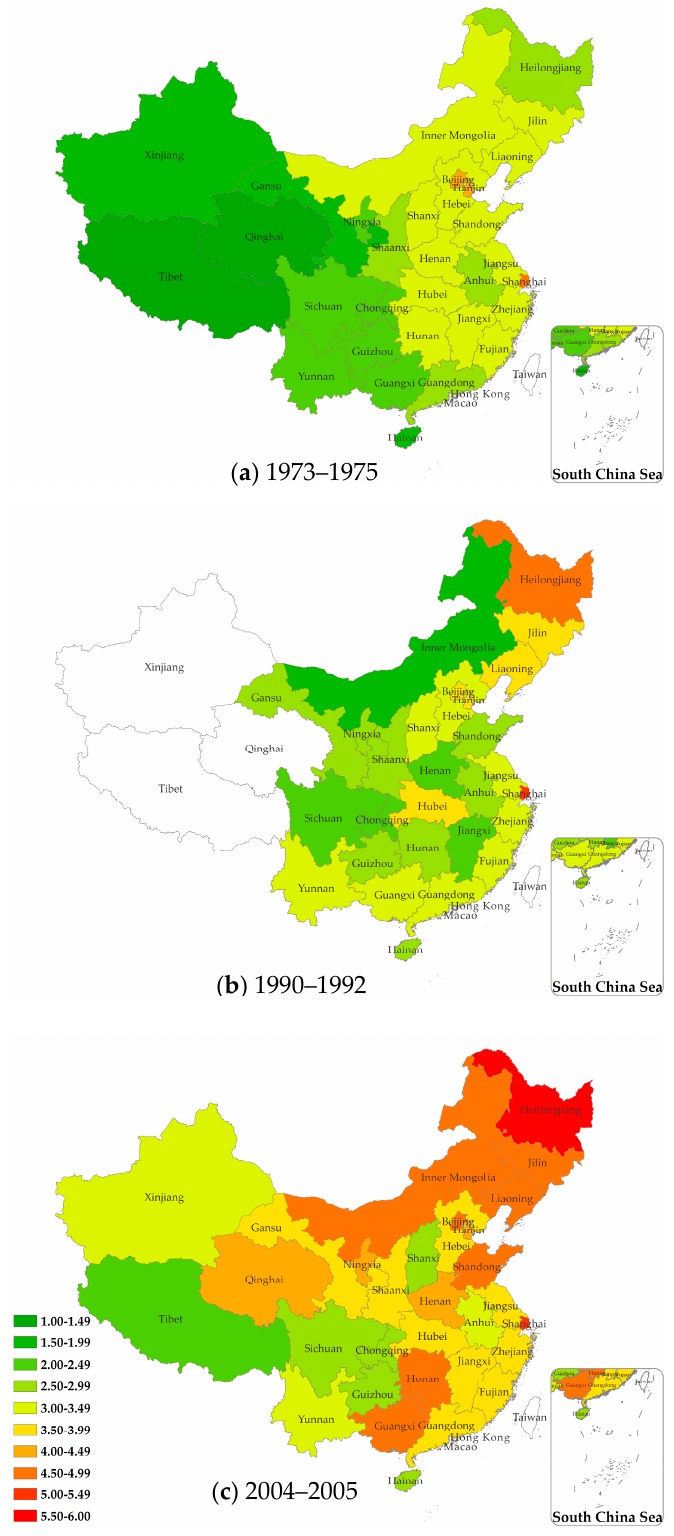
Figure 2. Female breast cancer age-standardized morality rates (ASMRs) by province (excluding Taiwan, Hong Kong, Macau) as recorded by three mortality surveys: ( a ) 1973–1975 the First National Survey of Death Causes; ( b ) 1990–1992 the Second National Retrospective Sampling Survey of Death Causes, with Xinjiang, Qinghai, Tibet not included; and ( c ) 2004–2005 the Third National Retrospective Sampling Survey of Death Causes. Map source: Sino Maps Press.